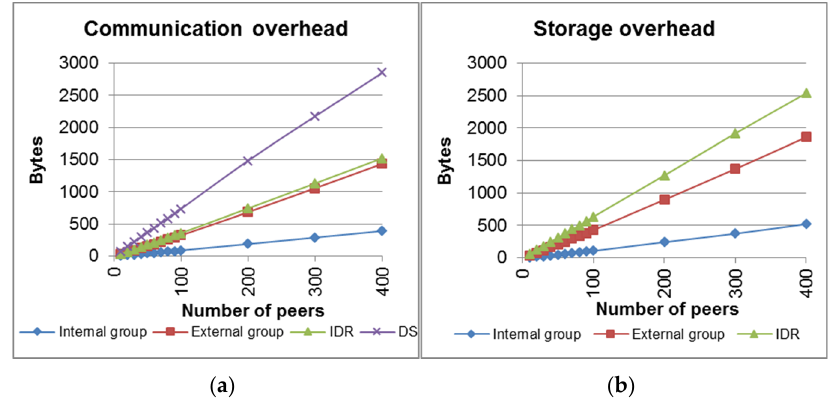
Figure 6. Communication ( a ) and storage ( b ) overheads in bytes for a system with delays from 50 to 550 milliseconds.